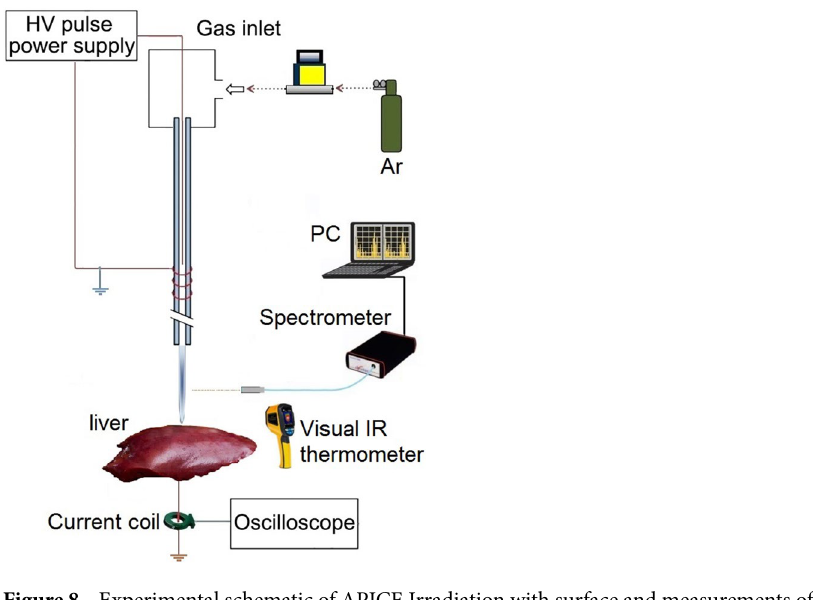
Figure 8. Experimental schematic of APJCE Irradiation with surface and measurements of electric shock and thermal effects results.